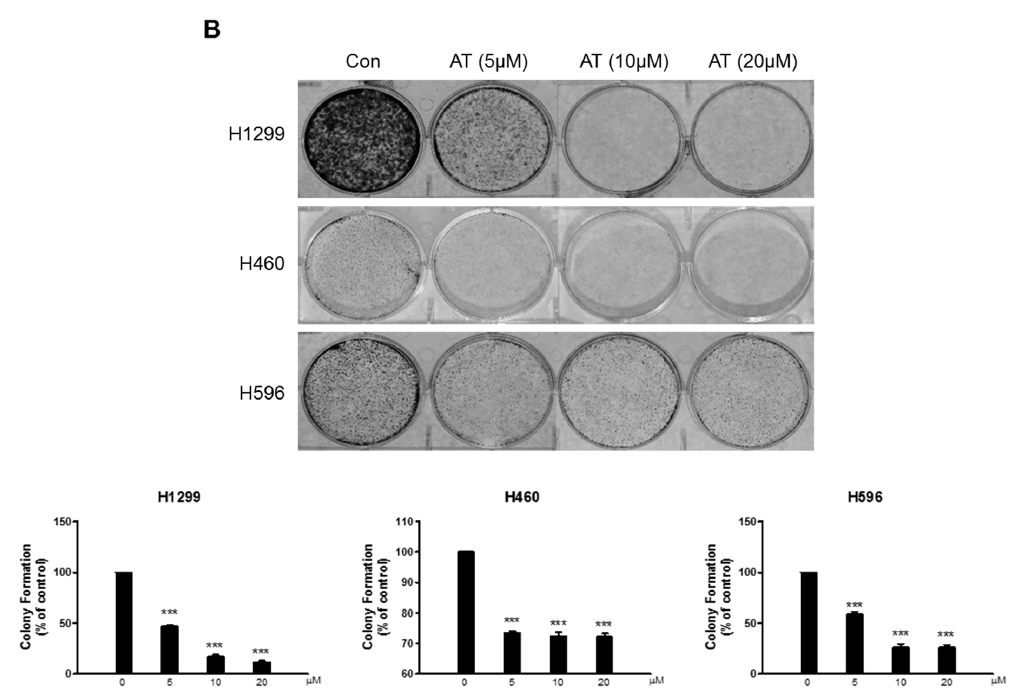
Figure 1. Cytotoxic and anti-proliferative effects of Atorvastatin in non-small cell lung cancers (NSCLCs). ( A ) Cytotoxicity of Atorvastatin in the H596, H460, H1299, and A549 cells. Four lung cancer cell lines were treated with various concentrations of Atorvastatin (0, 5, 10, and 20 μ M) for 24 or 48 h. Then cell viability was determined by MTT assay. ( B ) Anti-proliferative effect of Atorvastatin in the H596, H460, and H1299 cells by colony formation assay. Data represent means ± SEM of triplicate samples. *** p < 0.001 vs. untreated control.